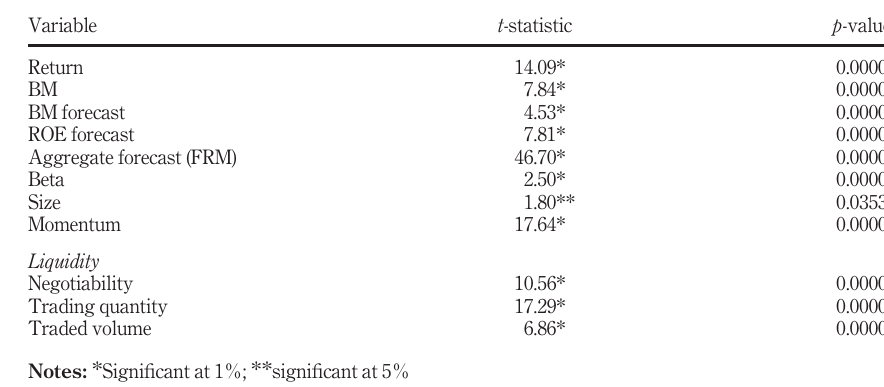
Table VI. Stationarity test for panel